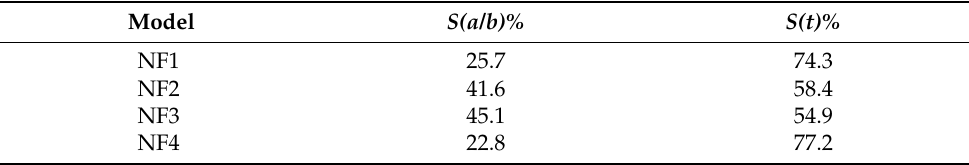
Table 7. Results of the sensitivity analysis ( S i ) of the GP